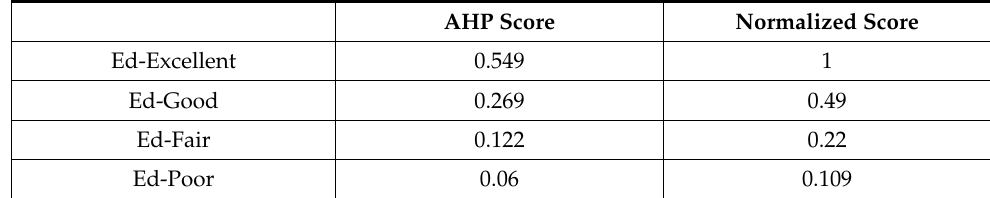
Table 13. AHP Score and Normalized Score for the Education Criterion.